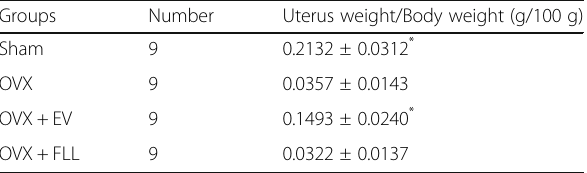
Table 1 The uterus coefficient in the different groups of rats Groups